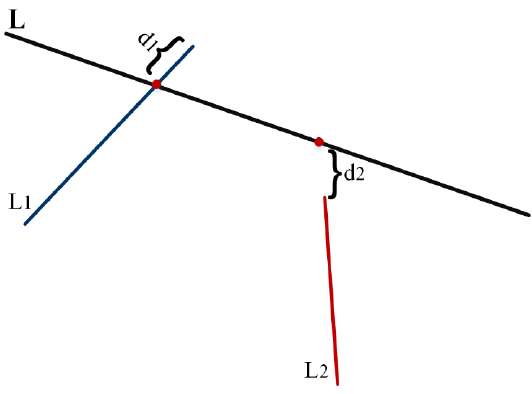
Figure 17. Overshoot and undershoot errors.